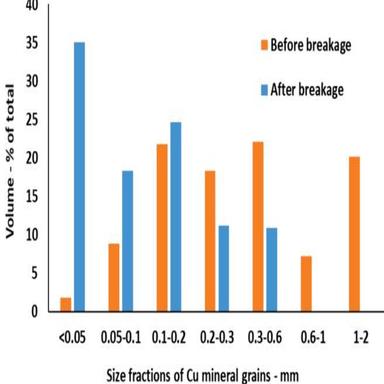
Size of Cu mineral grains, before and after breakage. Here size refers to equivalent diameter as defined by Equation.